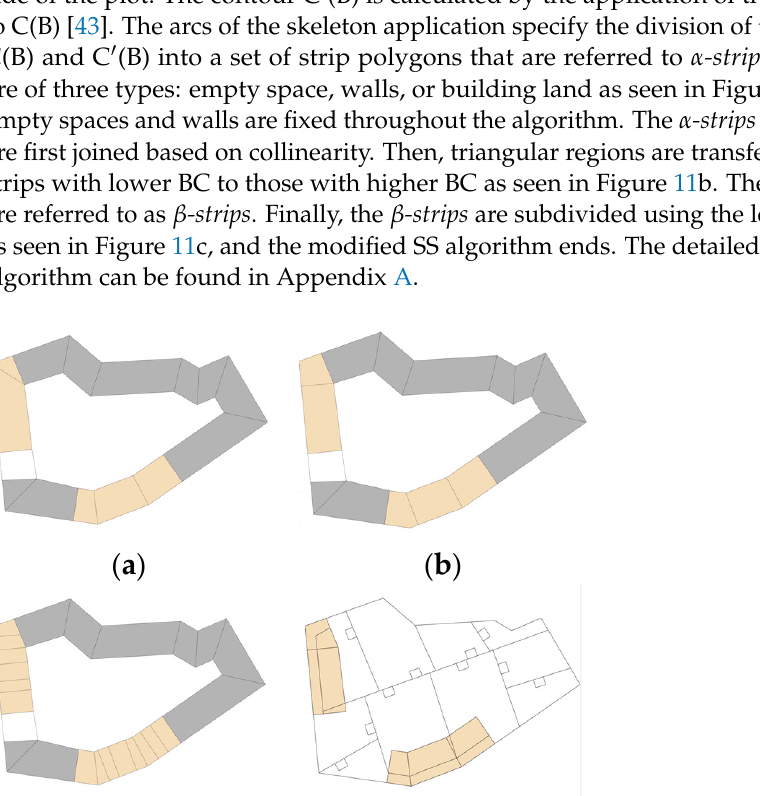
Table 4. An implicit model for 3D house reconstruction.